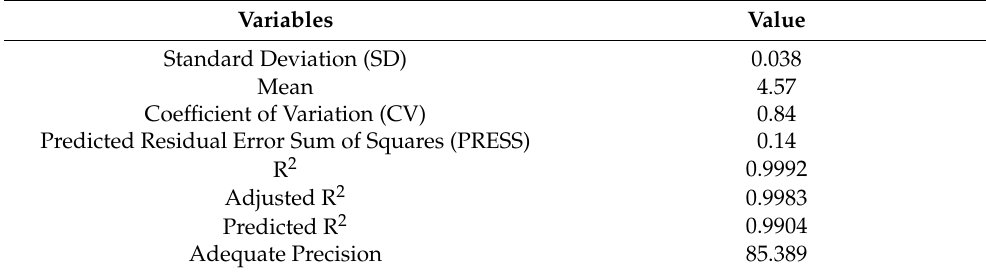
Table 1. Statistical parameter of the model equation as obtained from ANOVA models. Variables Value Standard Deviation (SD) 0.038 Mean 4.57 Coefficient of Variation (CV) 0.84 Predicted Residual Error Sum of Squares (PRESS) 0.14 R 2 0.9992 Adjusted R 2 Adequate Precision